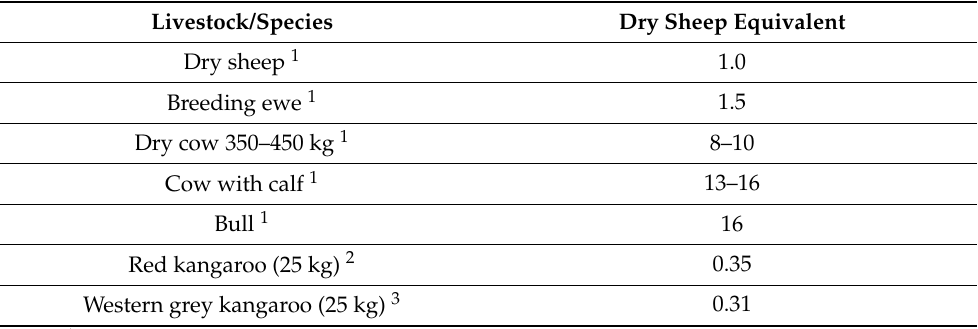
Table 1. Stocking rate equivalents (dry sheep equivalent) of sheep, beef cattle and two species of